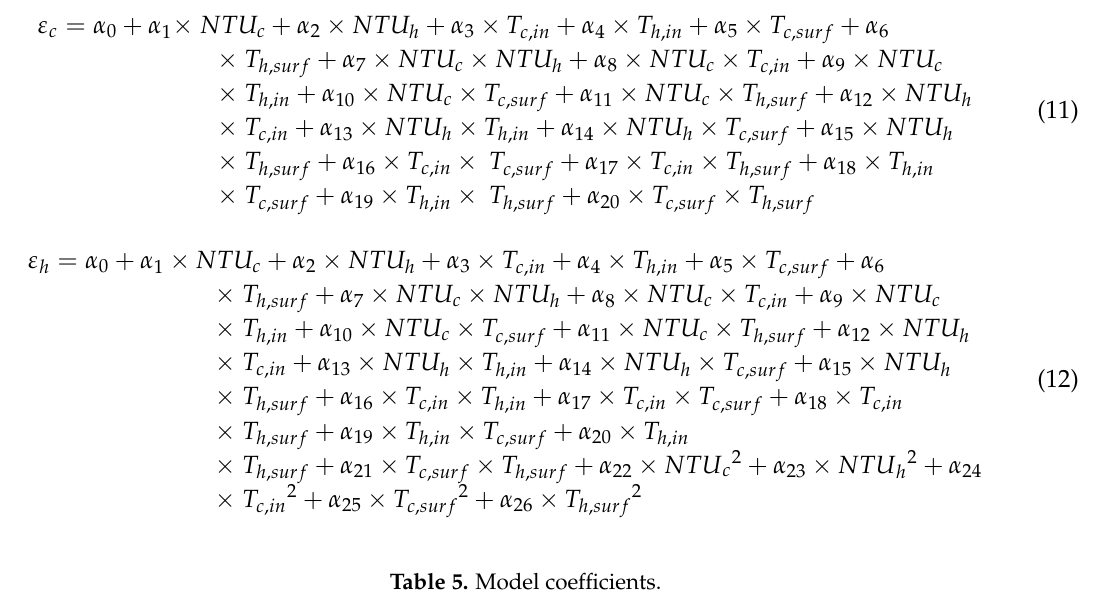
Table 5. Model coefficients.